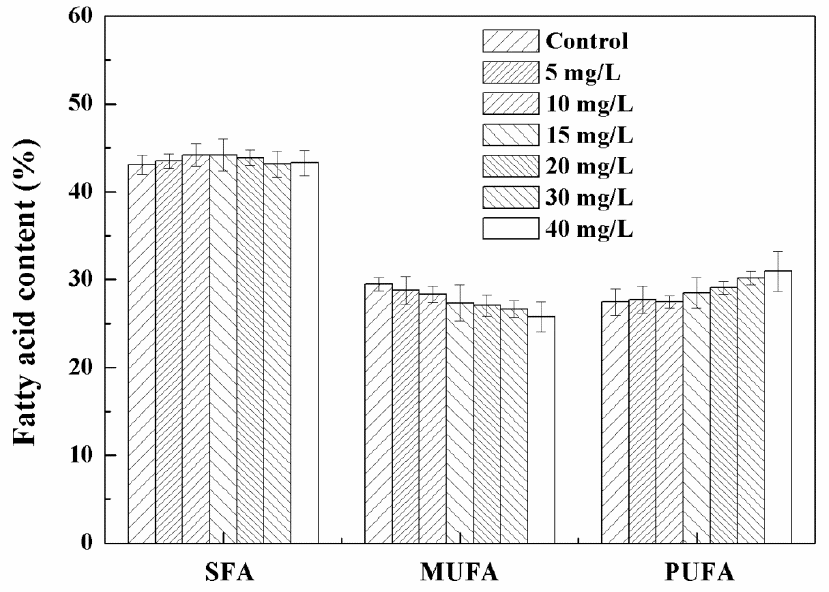
Figure 6. Fatty acid contents and components of Chlorella sp. UJ-3 exposed to different concentrations of Fe 3 O 4 NPs (Culture time: 21 days).